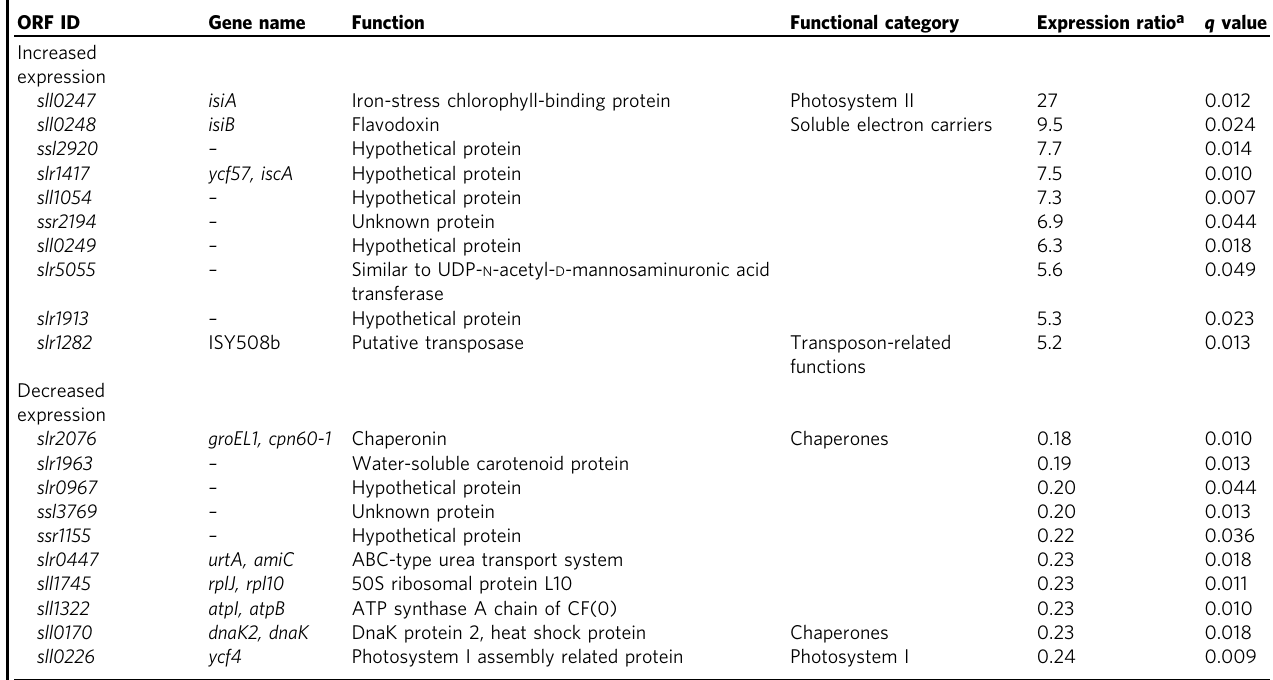
Table 2 Top 10 genes of increased or decreased expression levels with signi fi cant q values in Tol strain under HL condition (7000 μ mol m − 2 s − 1